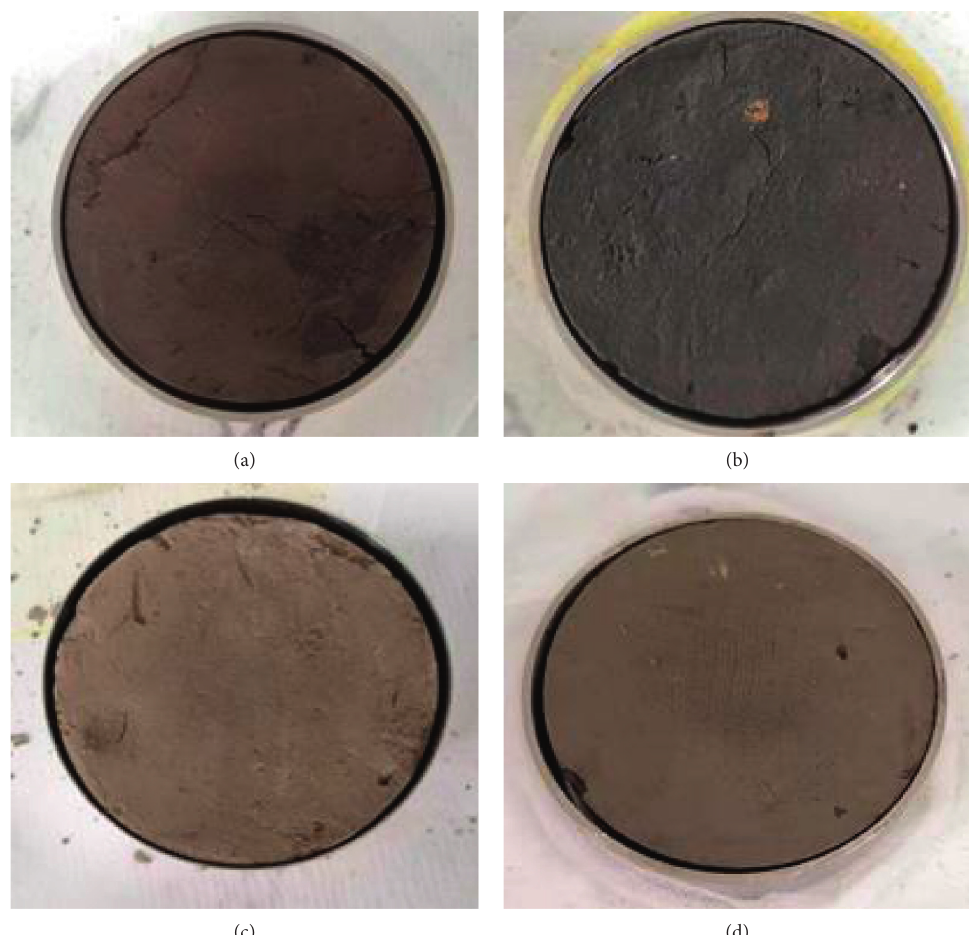
Figure 5: The changes in apparent characteristics of indoor soaked contaminated samples by TCE ( t � 379 days). (a) Layer (2). (b) Layer (3). (c) Layer (4). (d) Layer